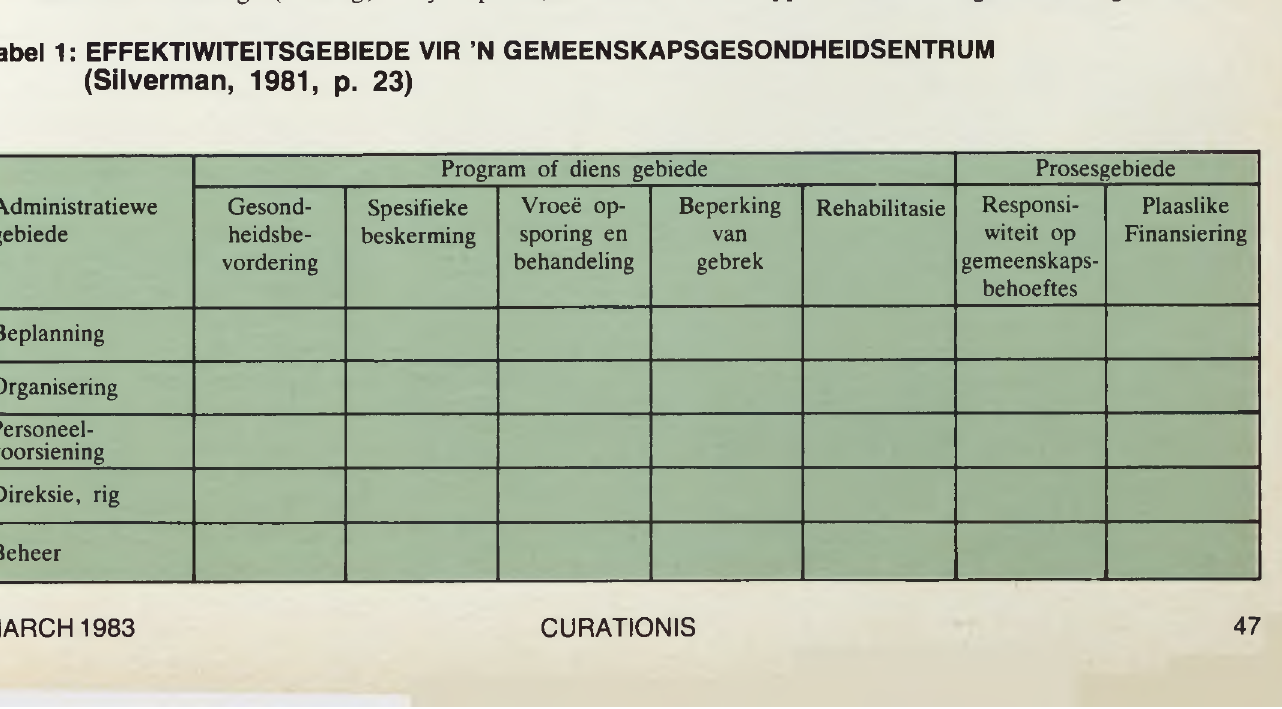
Tabel 1: EFFEKTIWITEITSGEBIEDE VIR ’N GEMEENSKAPSGESONDHEIDSENTRUM (Silverman, 1981, p.